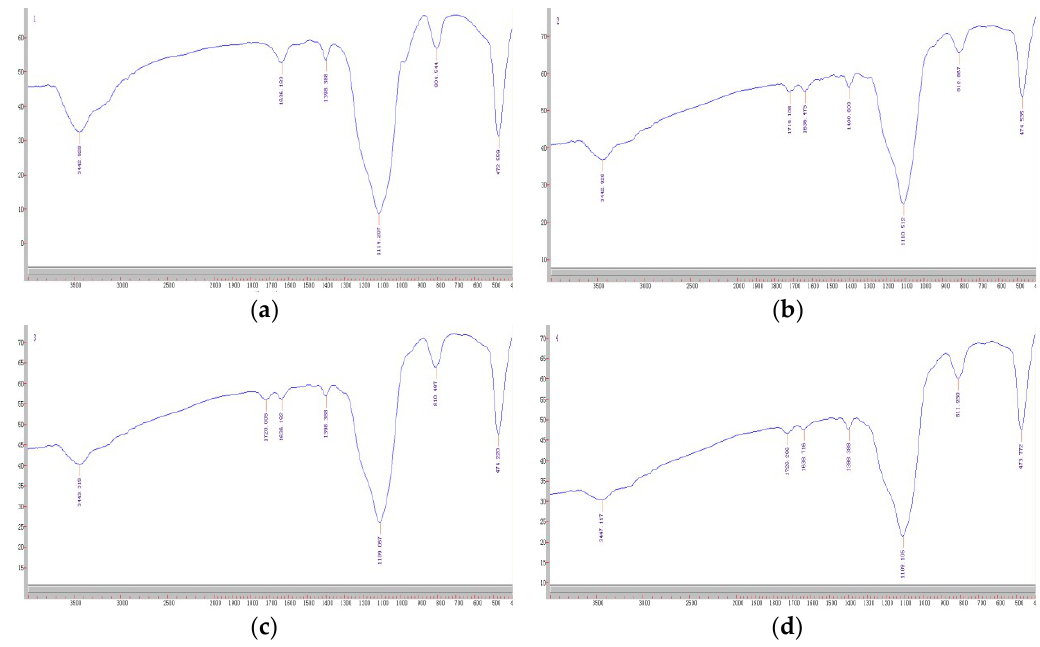
Figure 1. FT–IR spectra of activated silica gel ( a ), KH570@silica gel ( b ), MIP@silica gel ( c ), NIP@silica gel ( d ).